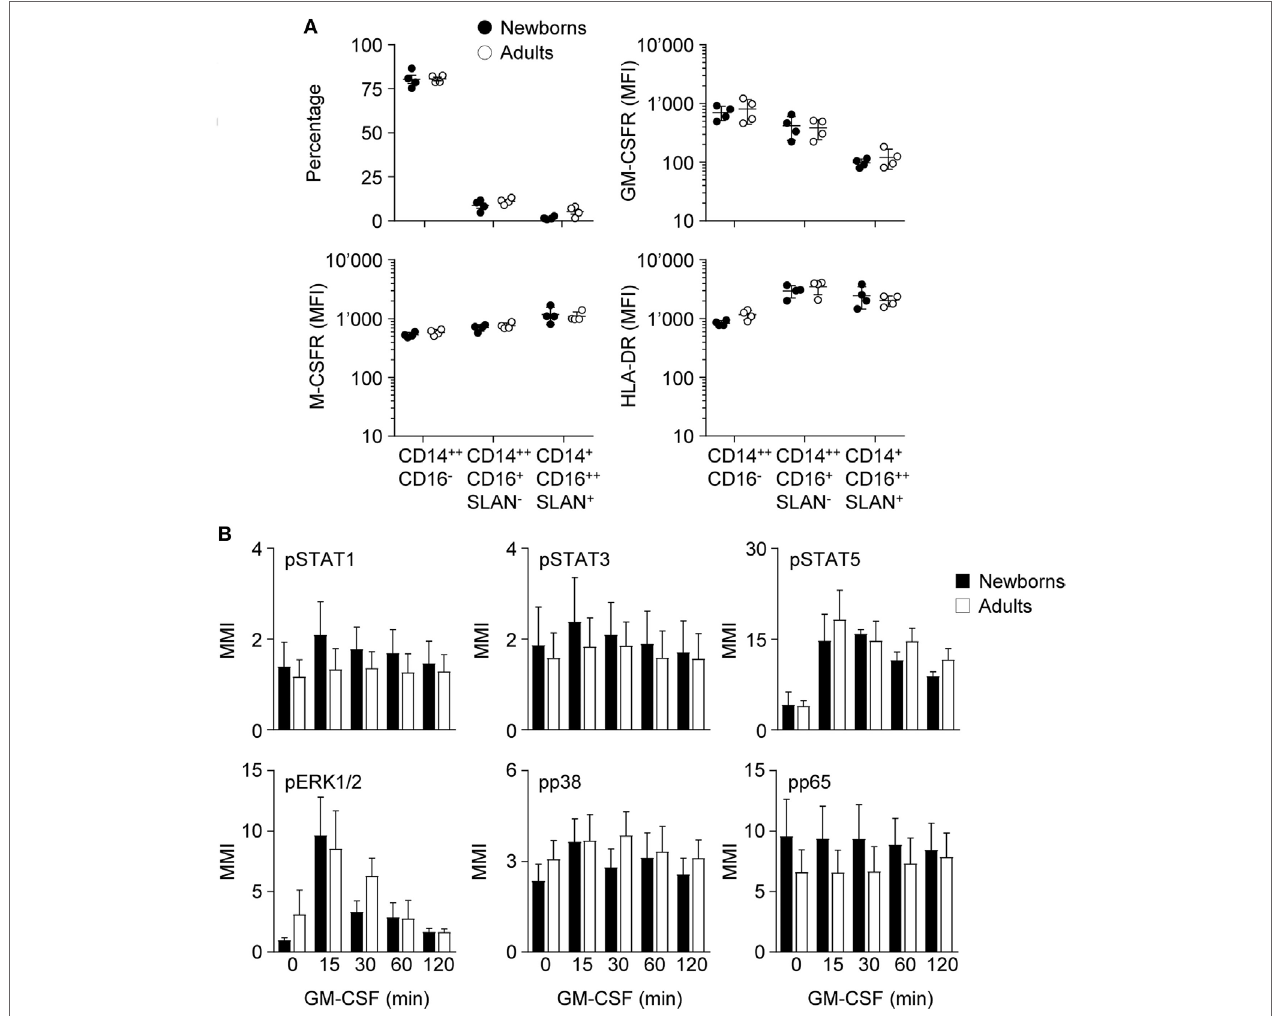
FigUre 3 | Proportions of monocyte subpopulations, expression of GM-CSF receptor (GM-CSFR), M-CSFR and HLA-DR and activation of intracellular signaling pathways by GM-CSF in newborn and adult monocytes. (a) Percentages of classical CD14 ++ CD16 − , intermediate CD14 ++ CD16 + SLAN − , and non-classical CD14 + CD16 ++ SLAN + subpopulations and mean fluorescence intensity of GM-CSFR, M-CSFR, and HLA-DR in newborn (black circles) and adult (white circles) monocytes were determined by flow cytometry. Each dot represents one healthy subject. Means ± SEM are depicted. (B) Nuclear levels pSTAT1, pSTAT3, pSTAT5, pp38, pERK, and pNF- κ Bp65 in newborn (black bars) and adult (white bars) monocytes exposed for 15–120 min to 50 ng/ml GM-CSF were analyzed by CyTOF. Mean magnetic intensities were determined. Data are means ± SEM from six newborns and six